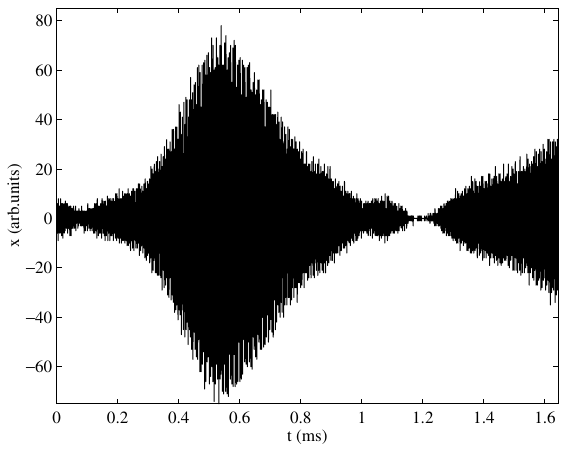
FIG. 9. Individual bunch motion.